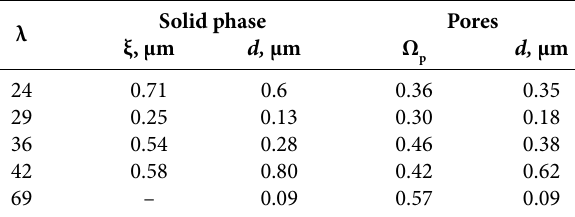
Table 1. The structural parameters of the porous PE